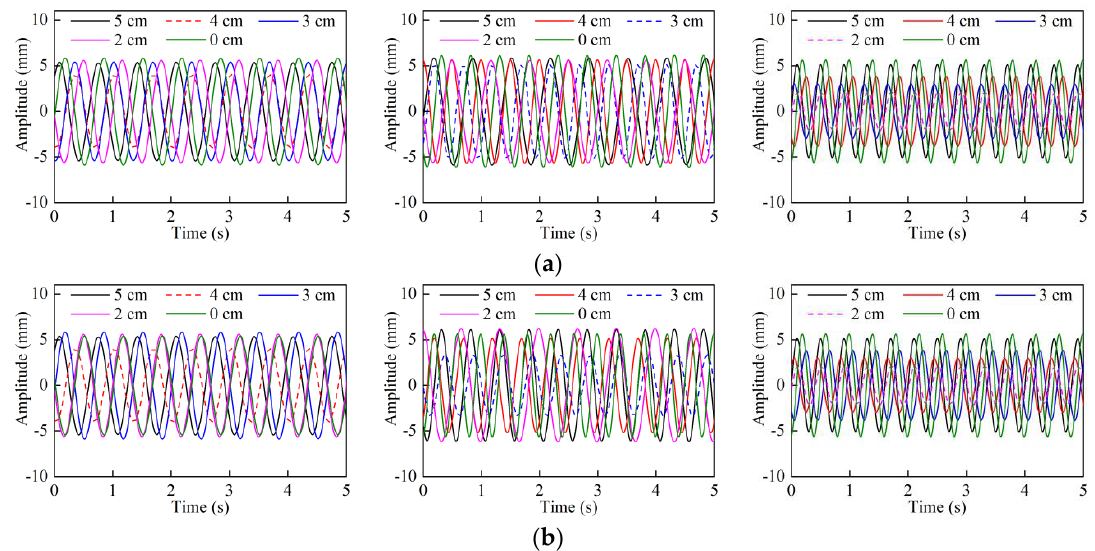
Figure 8. Displacement time histories under different base-frequency excitations: ( a ) Displacement time histories of the PMs in I layout; ( b ) Displacement time histories of the PMs in III layout.